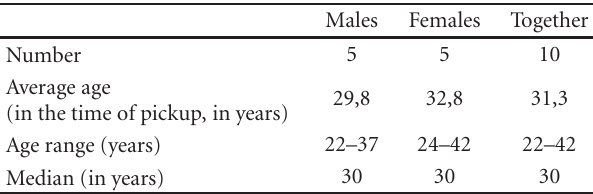
Table 1: Varicose vein group of samples.